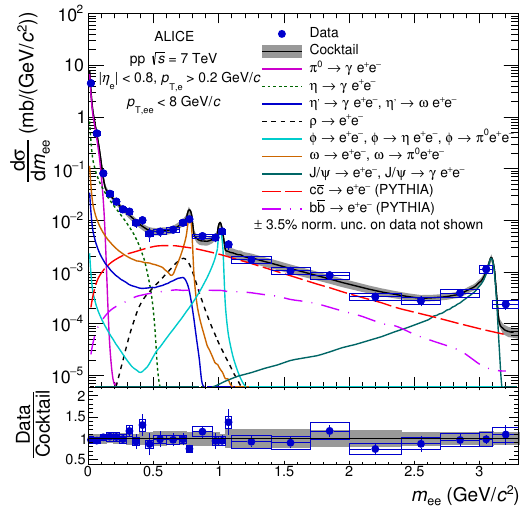
p s = 7 TeV in the ALICE